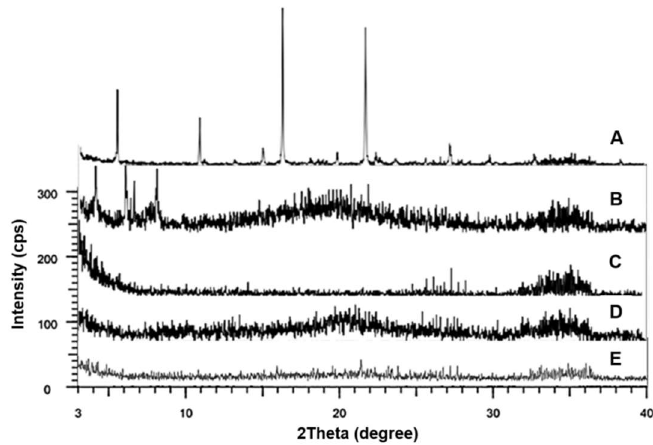
Figure 7. X-ray powder diffraction (XRD) patterns obtained from ( A ) pure CLC, ( B ) PC, ( C ) Neusilin ® US2, ( D ) CCS, and ( E ) F11.